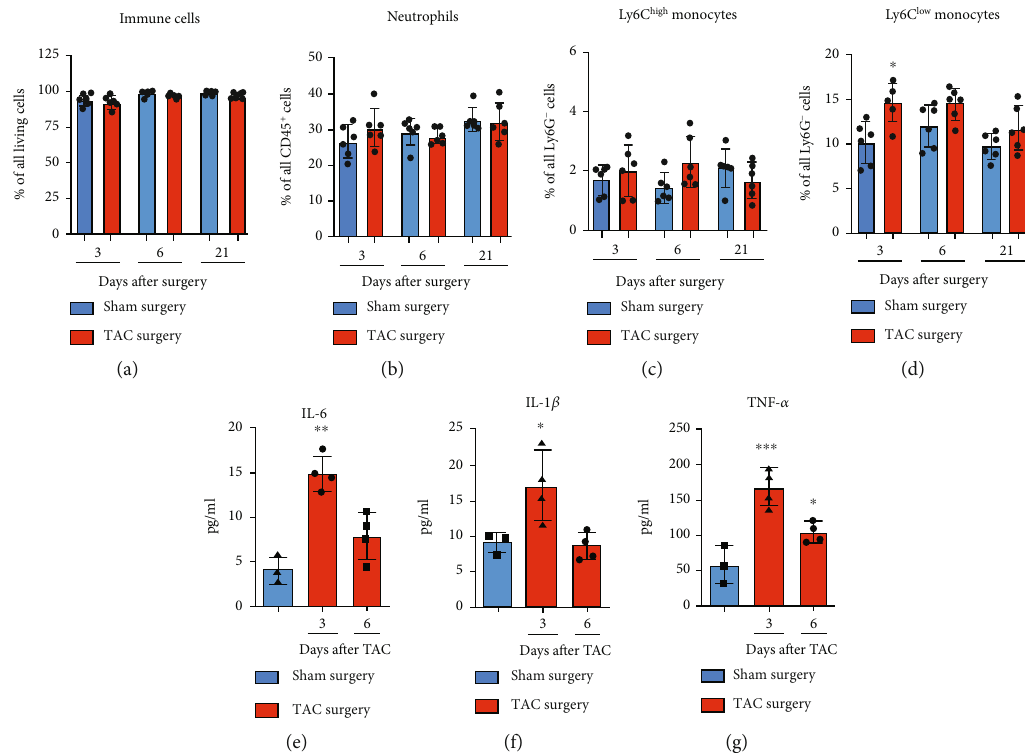
Figure 4: Innate immune cell quanti fi cation and cytokine levels in response to TAC in the blood. (a) – (d) The CD45 + immune cells, neutrophils, and Ly6C low and Ly6C high monocytes in the blood of the mice were quanti fi ed using fl ow cytometry. The particular cell subsets were de fi ned as follows: neutrophils as CD45 + CD115 - Ly6G + and monocytes as CD45 + CD115 + Ly6G - . In addition, the Ly6C high and Ly6C low monocytes were further discriminated according to the respective Ly6C surface expression. (e) – (g) The cytokine levels of IL-6, IL-1 β , and TNF- α in the serum of the mice were measured at days 3 and 6 after TAC or after day 3 after sham surgery. ∗ The above individual columns indicate the signi fi cant di ff erences between the TAC and respective sham group; ∗ P < 0 : 05 , ∗∗ P < 0 : 01 , and ∗∗∗ P < 0 : 001